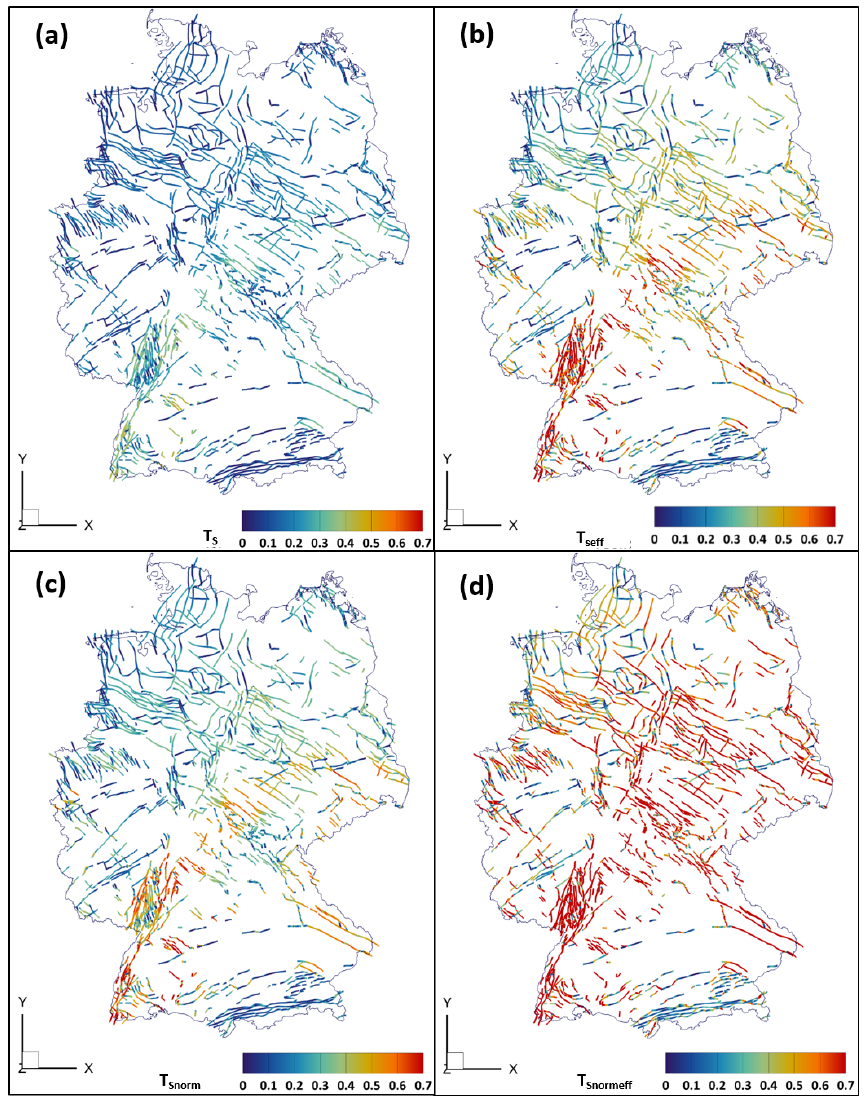
Figure 2. Top view of the slip tendency of the Vertical fault set calculated for four cases. Due to the vertical nature of the faults only the uppermost parts of the faults are visible. (a) T S ; (b) T Seff (with effective normal stresses); (c) T Snorm (normalized to a coefficient of friction of 0.57); (d) T Snormeff (with effective normal stresses and normalized to a coefficient of friction of 0.57). ©EuroGeographics for the administrative